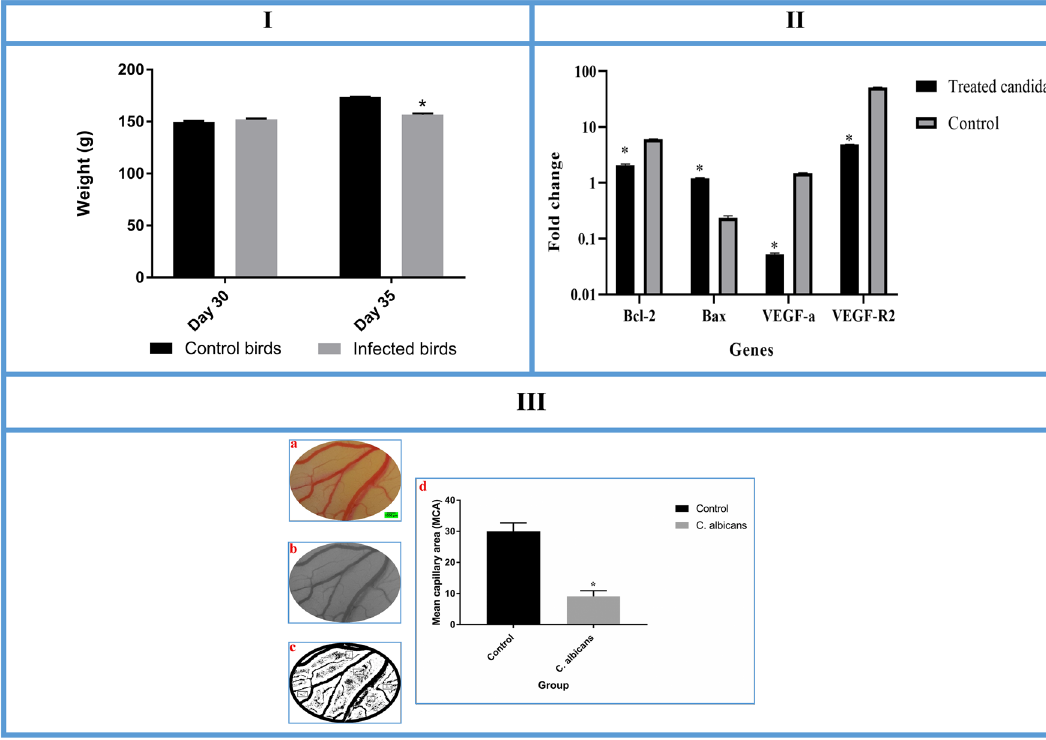
Figure 2. I (The body weight of the Alectoris chukar chicks at the start of experiment (day 30) and 5 days after infection (day 35) with comparison between control and Candida albicans infected birds. The infected birds showed significant weight loss compared to controls at the end of the experiment (error bars show standard error of mean; * p < 0.05).) II :(Expression levels of apoptotic-regulator genes following Candida albicans treatment. The expression level of Bax mRNA in the partridge extra-embryonic membranes is increased but the expression levels of Bcl-2, VEGF-A and VEGF-R2 are decreased in the LM-treated groups compared to controls. (Error bars show standard error of mean). III (The mean capillary area (MCA) analysis on the partridge’s extra- embryonic membrane. ( a ) A constant area (125 mm2) is extracted from captured image. ( b ) Extracted area has been converted to a binarized image. ( c ) Five defined areas (rectangular) without any branch vessels are selected and the percentage of the areas containing black pixels is quantified for the MCA. The black pixels of the image indicate the red color, or blood, in the original image. ( d ) MCA is significantly decreased in the fungus inoculated group compared to the control (error bars show standard error of mean; * p < 0.000, T